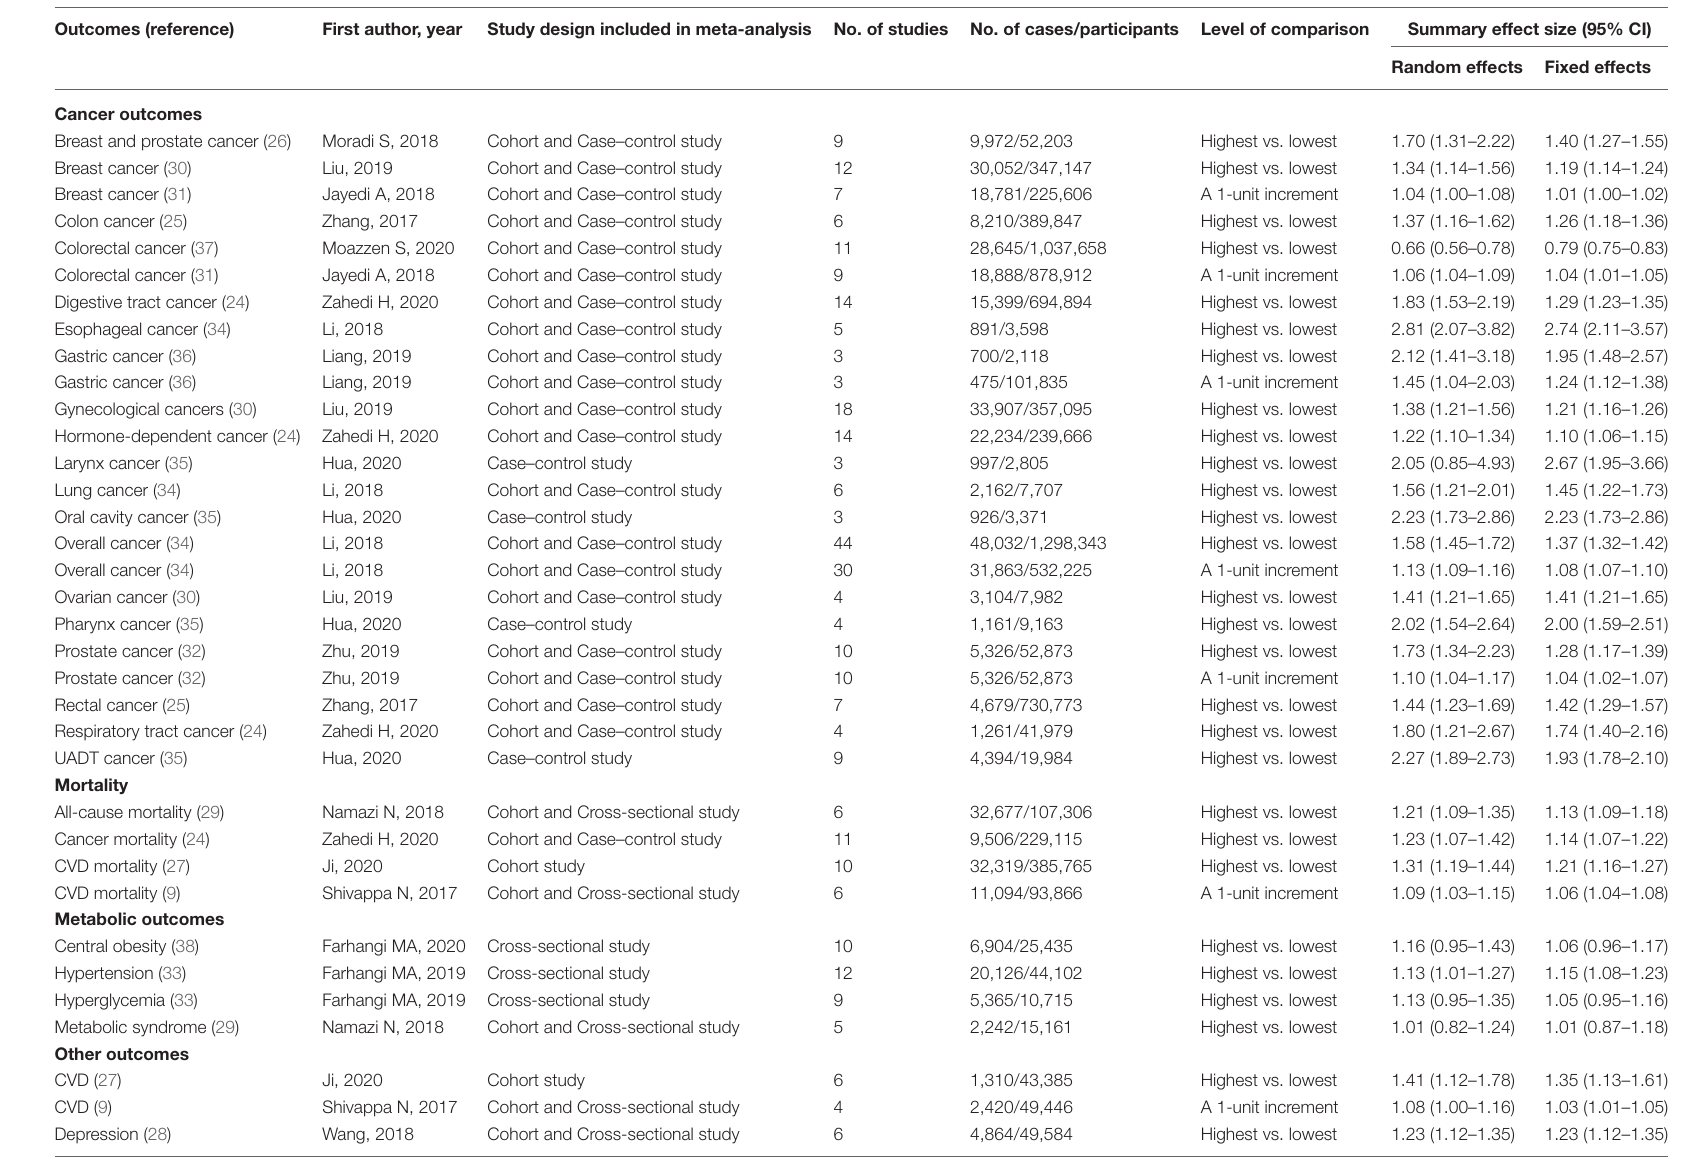
TABLE 1 | Characteristics and quantitative synthesis of the eligible meta-analyses of DII for health